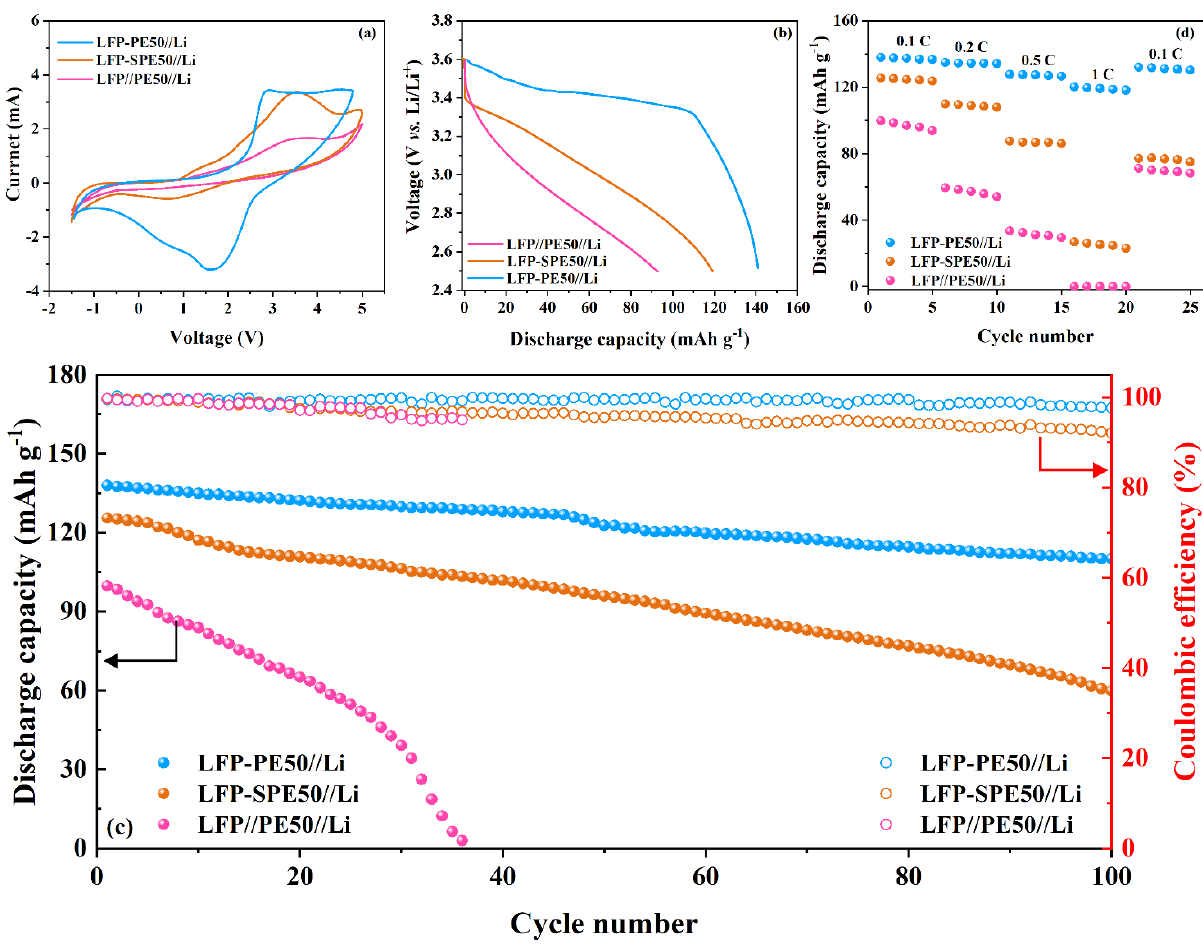
Figure 7. ( a ) CV plots of compared polymer electrolytes at room temperature with a scan rate of 1 mV s − 1 , ( b ) CD plots of PE − 50, ( c ) cycling performance of half − cell at 0.1 C and ( d ) rate